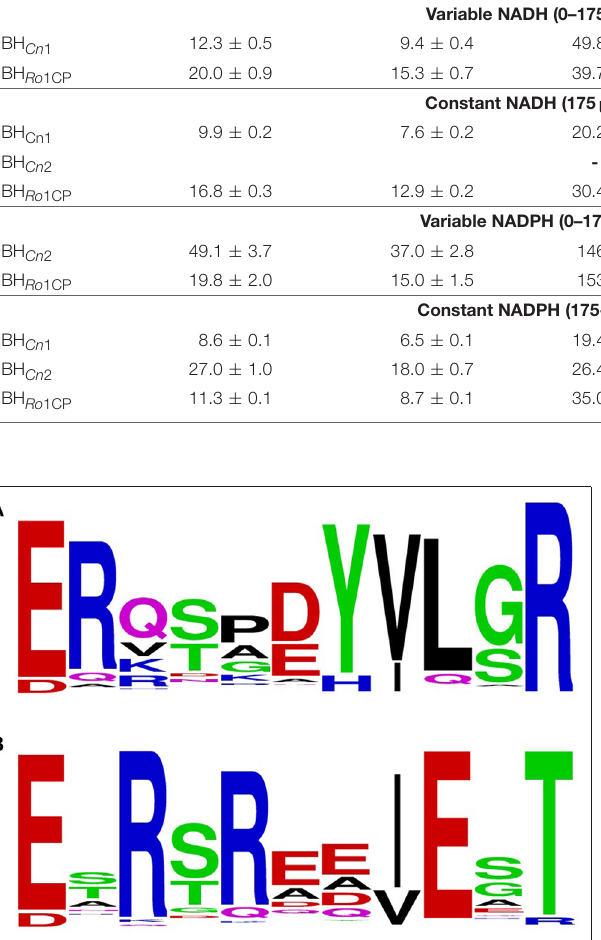
HPLC—product formation